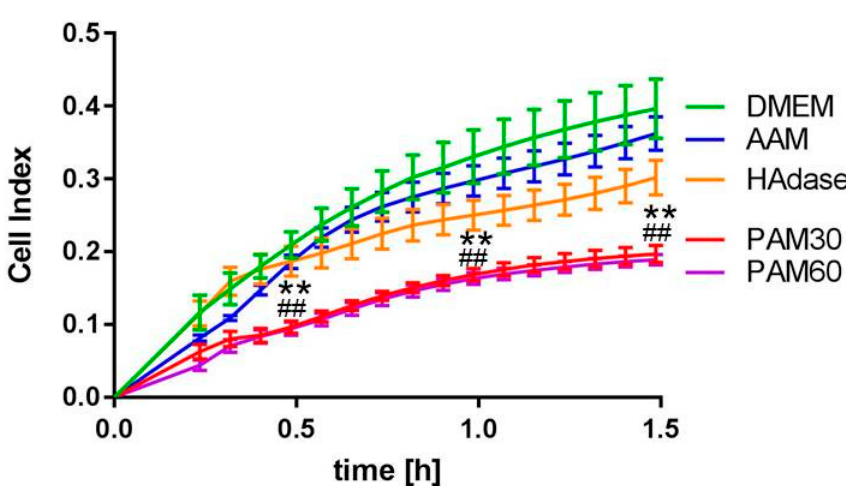
Figure 4. Online monitoring of HaCaT cell adhesion in PAM30, PAM60, and control media up to 1.5 h. Note that PAM impaired the cell attachment process significantly and to a greater extent than the HAdase-cleavage did. (xCELLigence Real-time Cell Analysis, normalized cell index; mean ± s.e.m., n = 3, Mann–Whitney test, ** p < 0.01 PAM30 vs. DMEM, ## p < 0.01 PAM60 vs. DMEM). Abbr.: DMEM: Dulbecco’s modified Eagle’s medium, PAM30: 30 s plasma-treated DMEM, PAM60: 60 s plasma-treated DMEM, AAM: 60 s argon gas-treated DMEM, HAdase: DMEM with hyaluronidase.